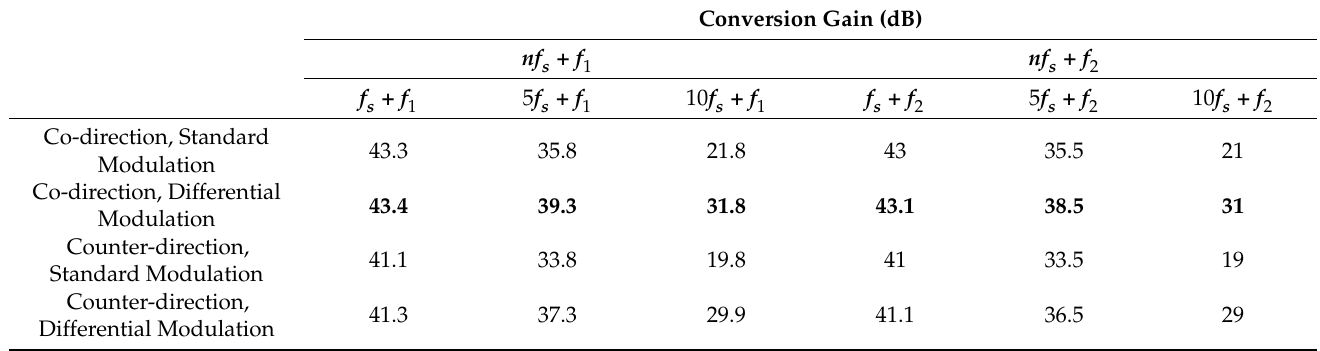
Table 2. Simulated up-conversion gains of the simultaneous up-converted signals at nf s + f m in the co- and counter-direction schemas for the standard and differential modulation